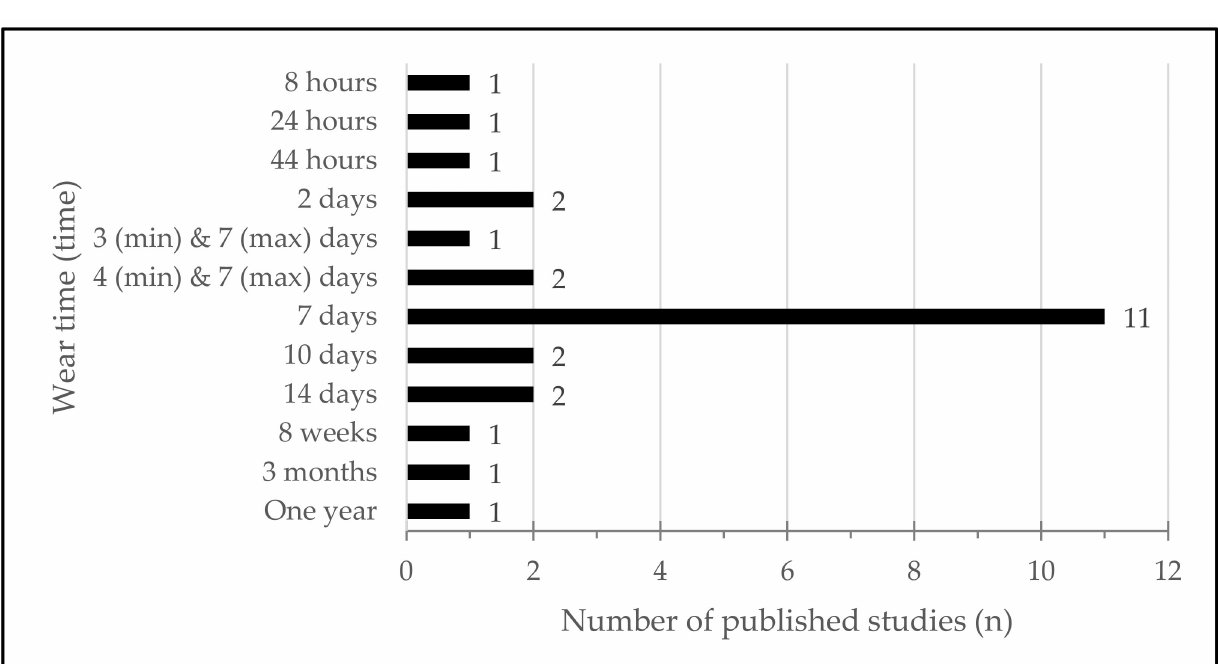
Figure 6. Wear time protocol of included